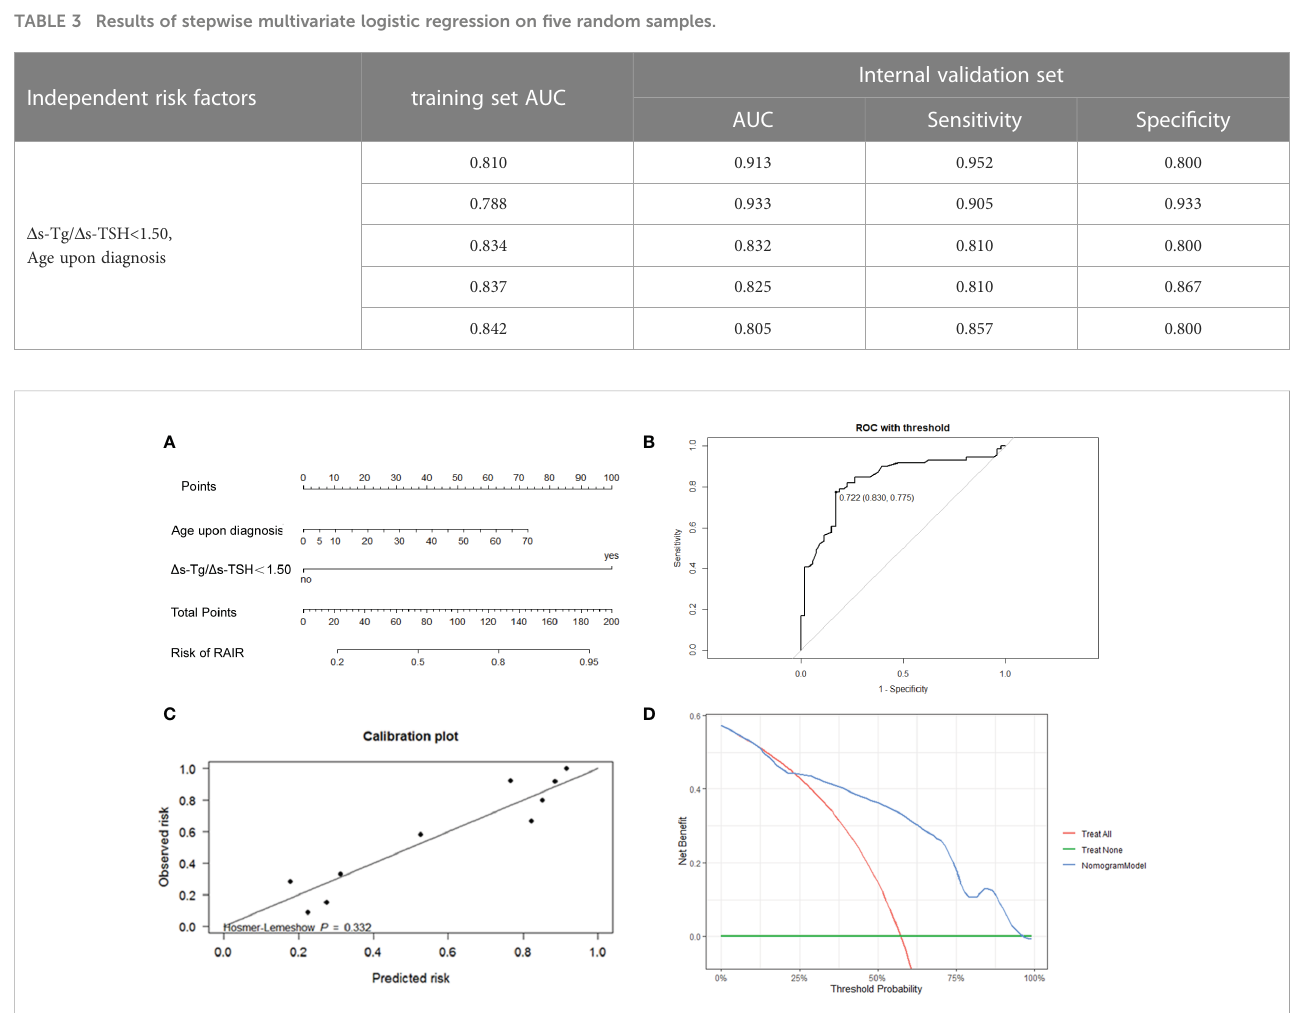
FIGURE 4 (A) Nomogram to develop the risk of RAIR-DTC in DTC patients with distant metastasis. (B) ROC curves of the nomogram model for predicting RAIR. AUC:0.830, sensitivity:0.775, speci fi city: 0.830. The cut-off value of risk of RAIR is 0.722. (C) Calibration curve. (D) Decision